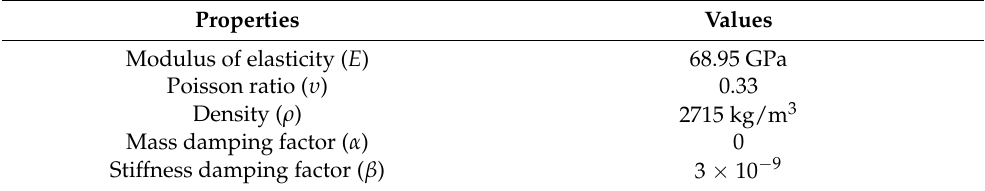
Table 3. Properties of piezoelectric conforming to grade PIC 151 [28].